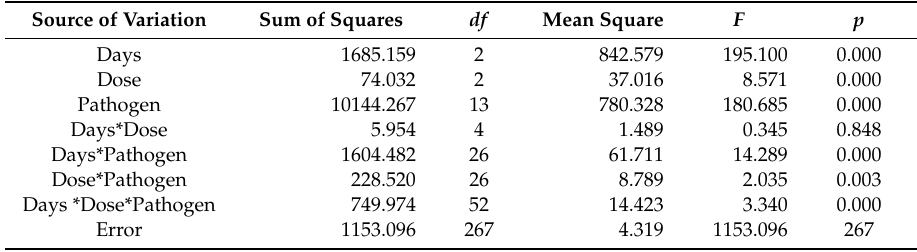
Table 5. Analysis of variance (ANOVA) results for radial growth of the pathogenic fungi cultured in Epicoccum purpurascens at 5, 10, and 15 dpi